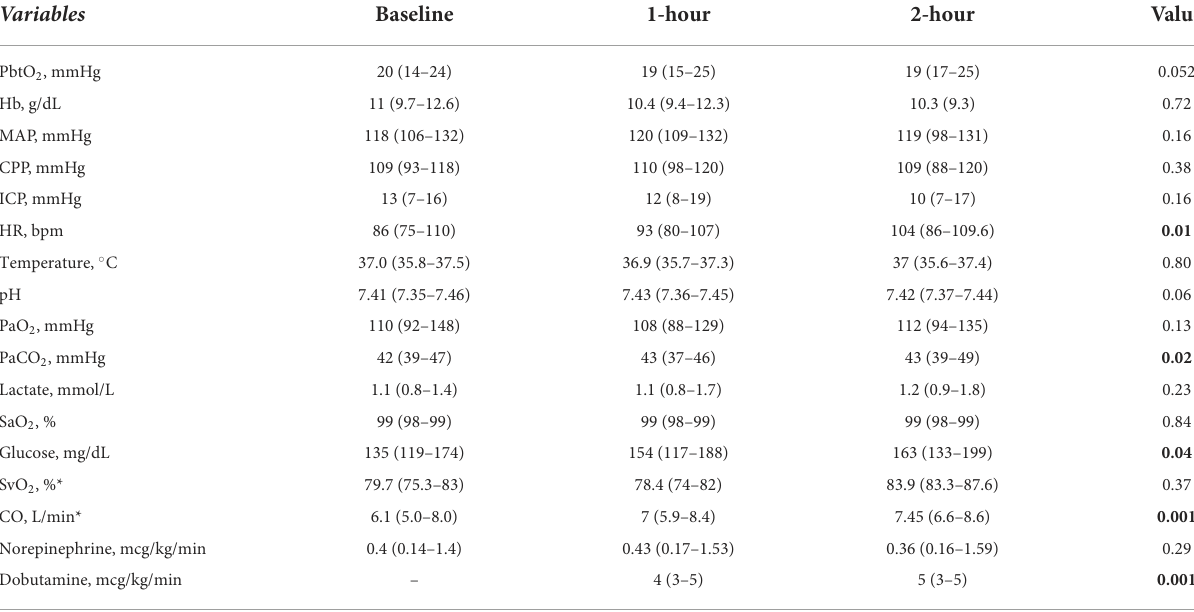
TABLE 1 Changes in main variables from baseline values after inotropic agents